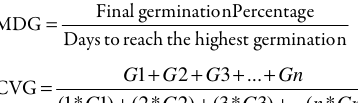
Fig. 1. Interaction plot of seed germination percentage under hormone seed priming and ageing treatments